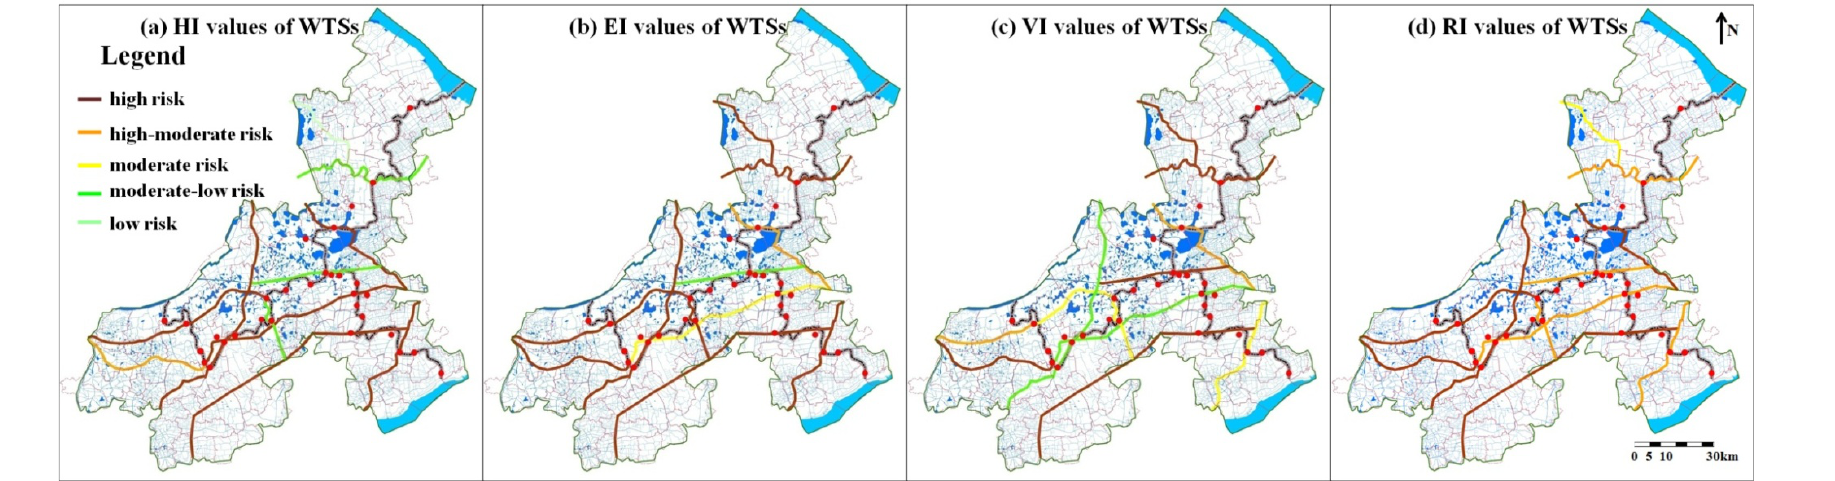
Figure 9. Spatial distribution of HI, EI, VI and RI values of the